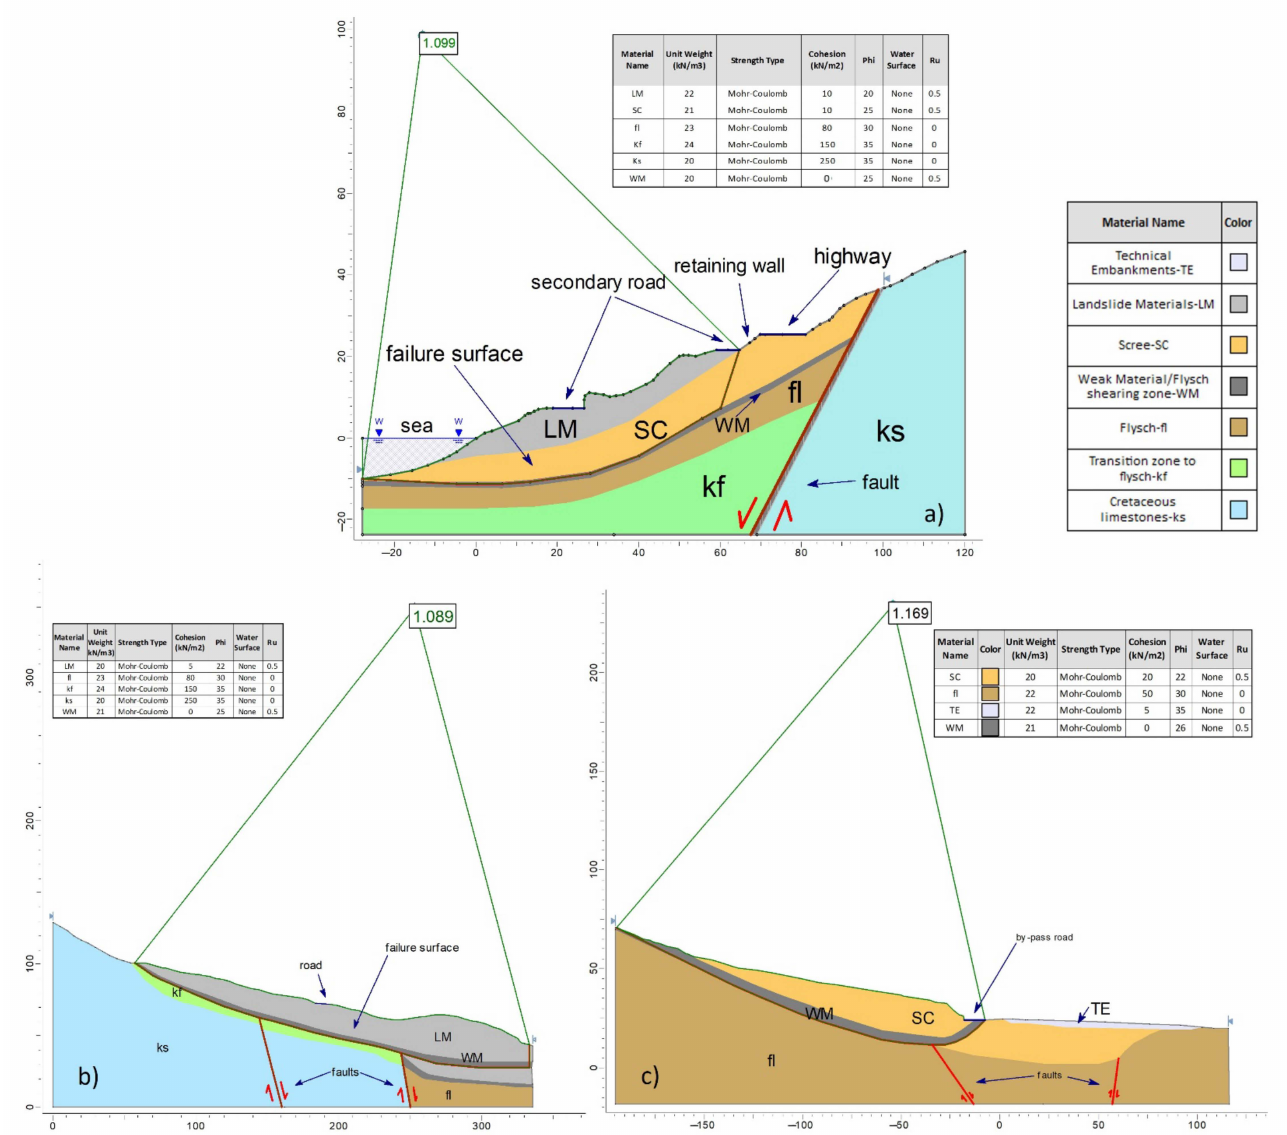
Figure 10. Simplified geotechnical cross-sections of the three studied landslide cases ( a ) Panagopoula area (PAN), ( b ) Karya village (KAR), ( c ) Platanitis area